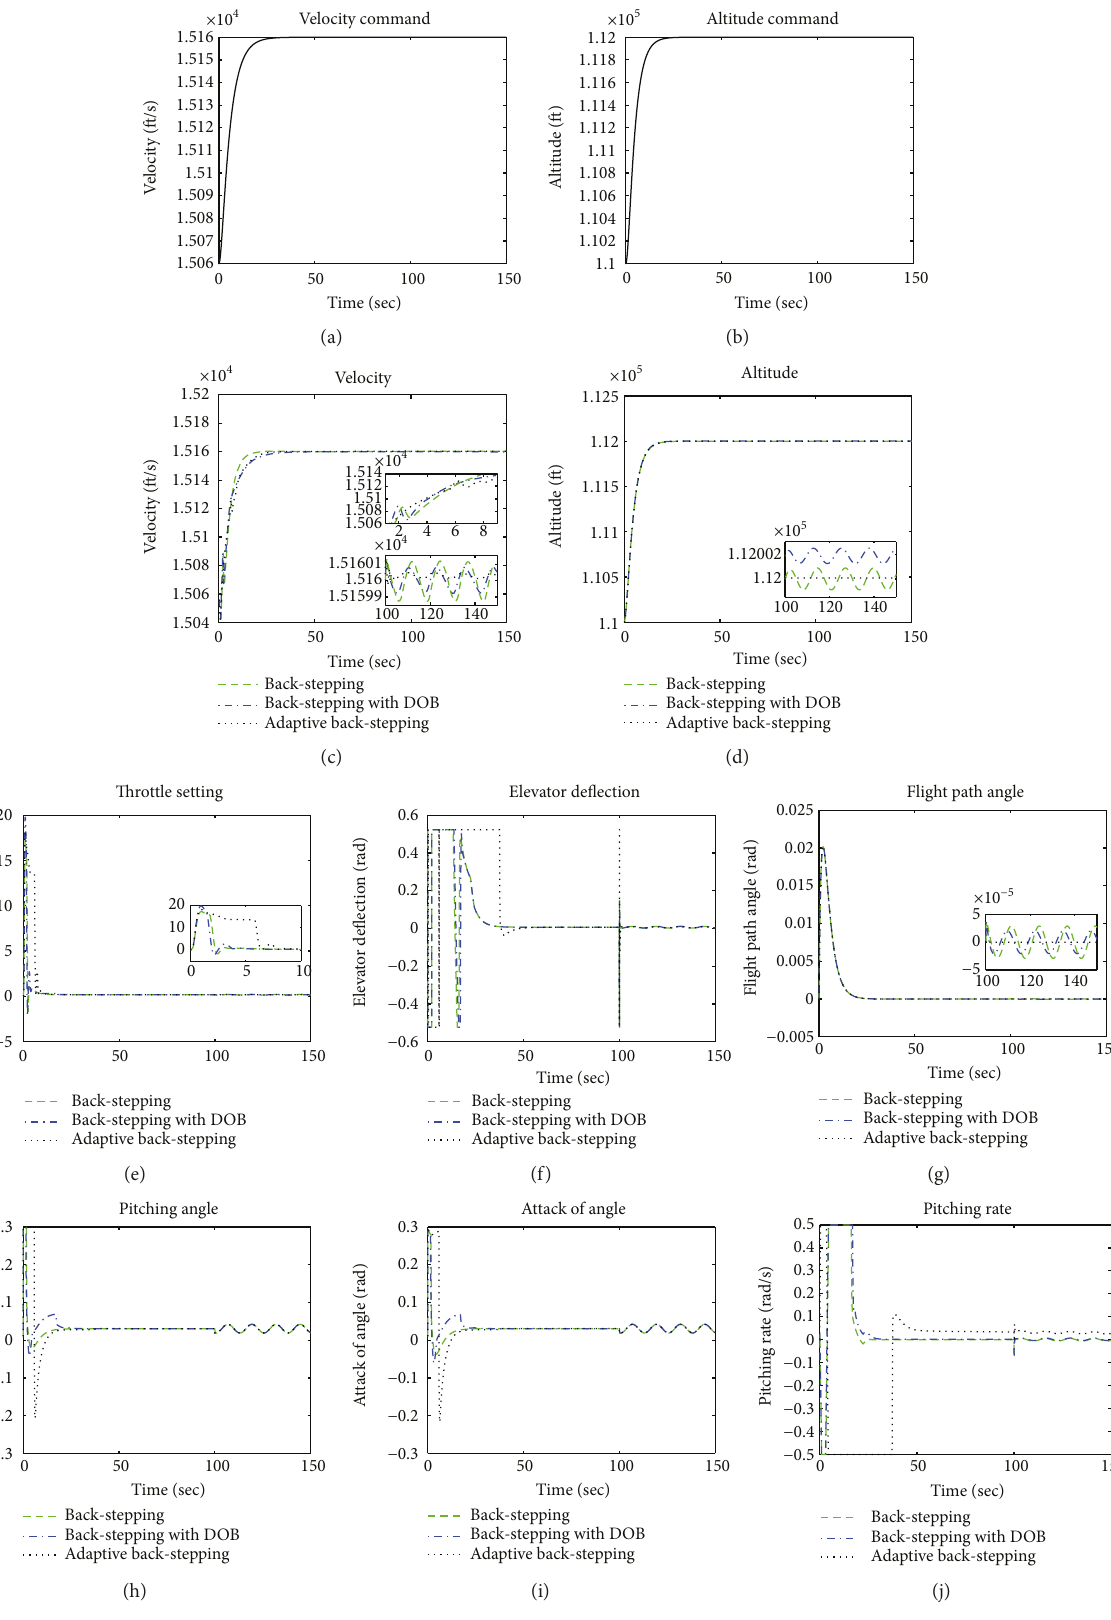
Figure 7: Command, response, and controller. The uncertainty terms and external disturbances are added into the